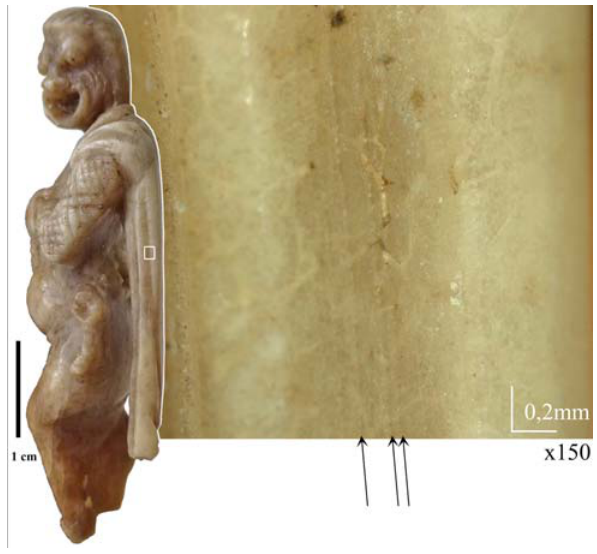
Figure 9: Left view of the fi gurine from I ž a - Leànyvàn. The lines of the cape have been crafted with a tool, as displayed by the regular axial striations ( black arrows ) covering the bottom of the magni fi ed groove, in a similar way as for the lines from the comedian ’ s head. Scale of the fi gurine, 1 cm ( Photo: Éva David )